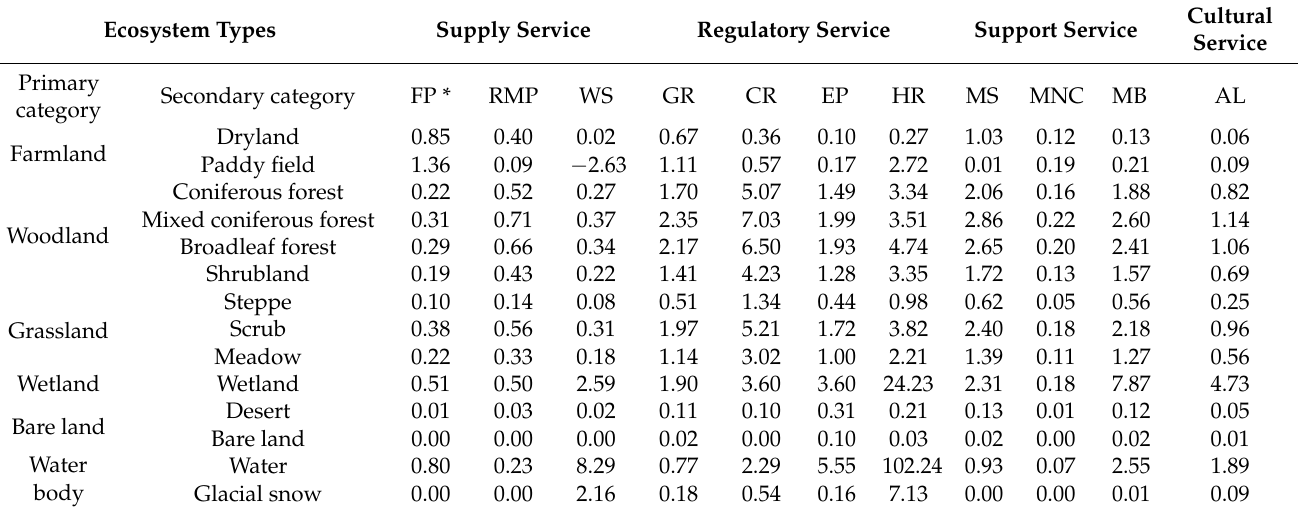
Table 1. The equivalents of ecosystem service value supplied by per unit area of ecosystem in China (Xie et al.